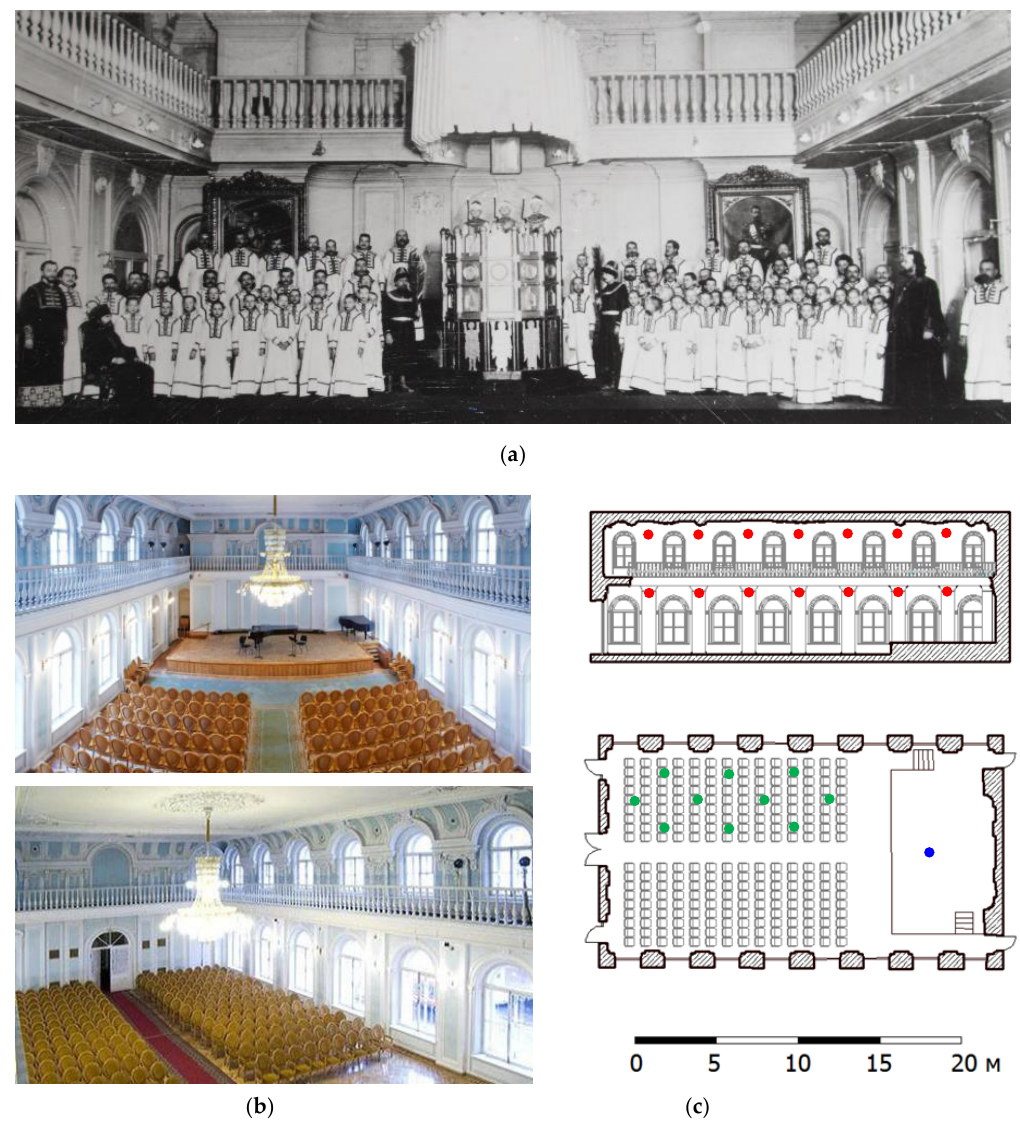
Figure 7. Rachmaninov Hall of the Moscow Conservatory before 1917 ( a ) and now ( b ); its section and plan ( c ). Red points on the section indicate the displacement of the resonant vessels in the side walls; the blue point on the plan is the position of the sound source; green points are the positions of the microphone.